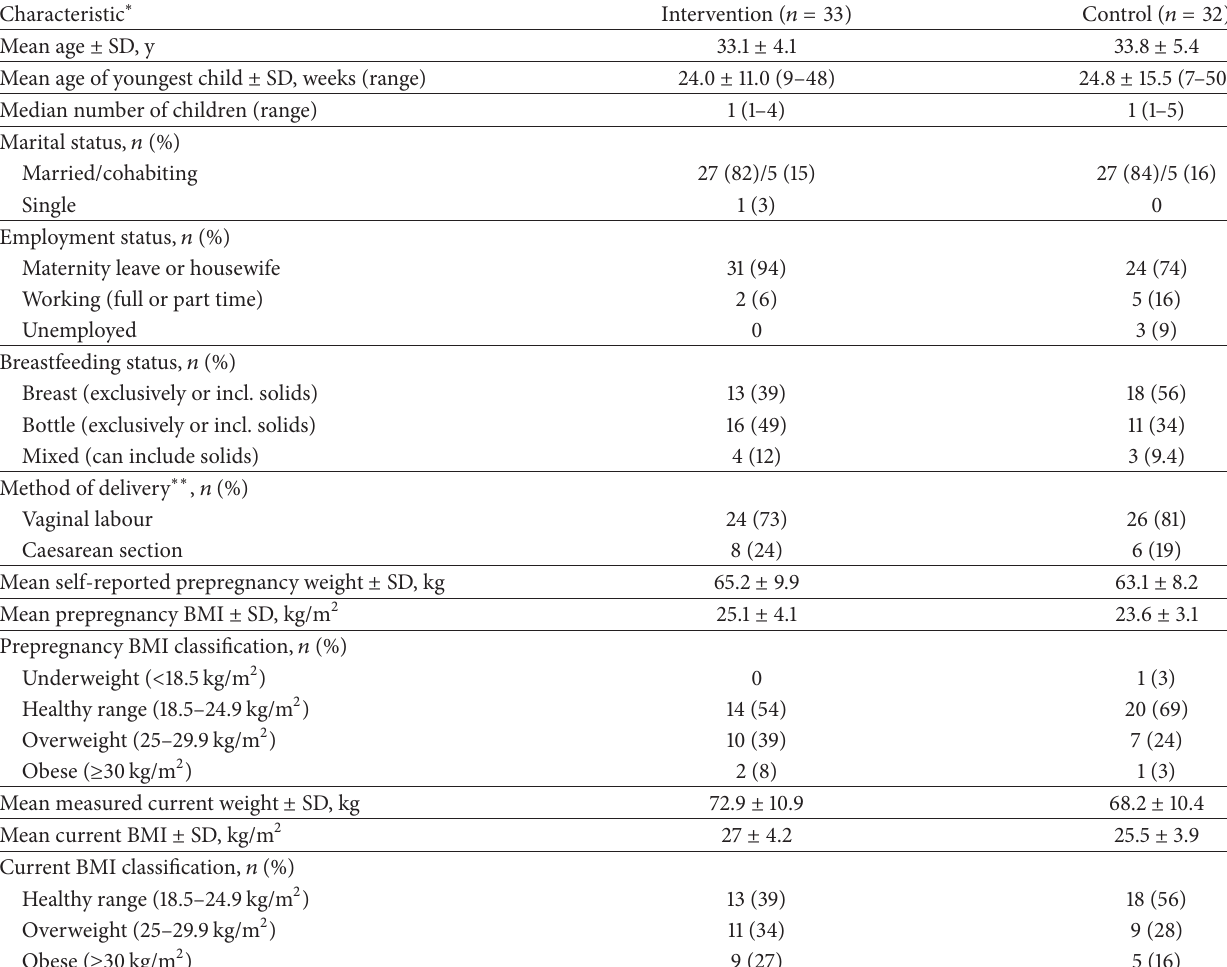
Table 1: Participant baseline sociodemographic and clinical